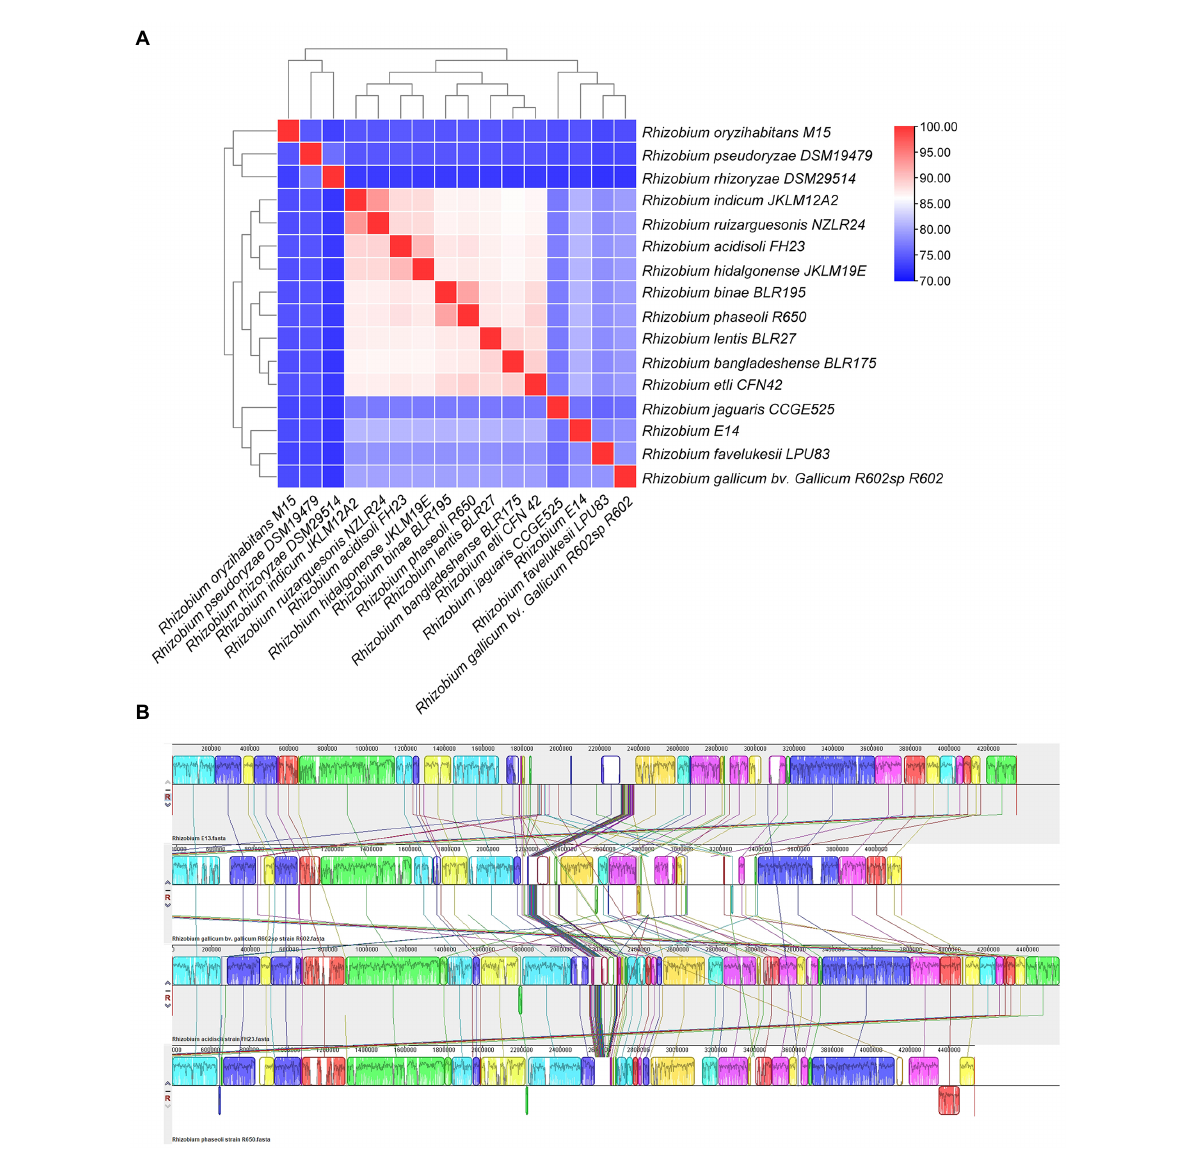
FIGURE 7 The average nucleotide identity analysis and comparative genome analysis. ( A ) The heat maps of ANI (average nucleotide identity) between strain WYJ-E13 and other 15 Rhizobium genus. ( B ) Genome-to-genome alignment of Rhizobium sp. WYJ-E13, Rhizobium acidisoli FH23, Rhizobium gallicum bv. gallicum R602sp strain R602 and Rhizobium phaseoli R650 used a progressive mauve software with a window of 1,000 nucleotides. WYJ-E13 was set as the reference genome. Boxes with the same color indicate the syntenic regions. Boxes below the horizontal line indicate inverted regions. Rearrangements are shown by colored